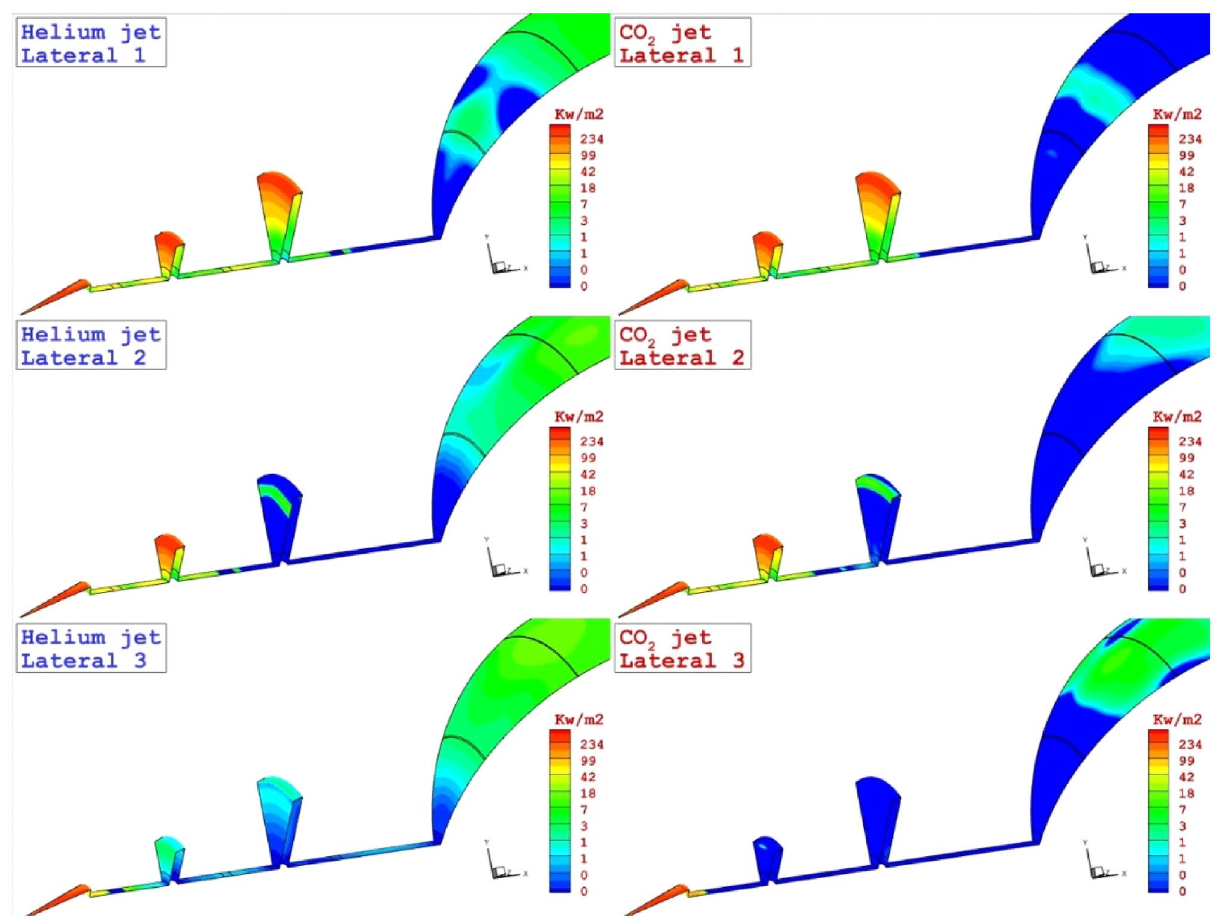
Figure 8. Heat transfer rate on the main body and disk of the different lateral coolant injection systems.